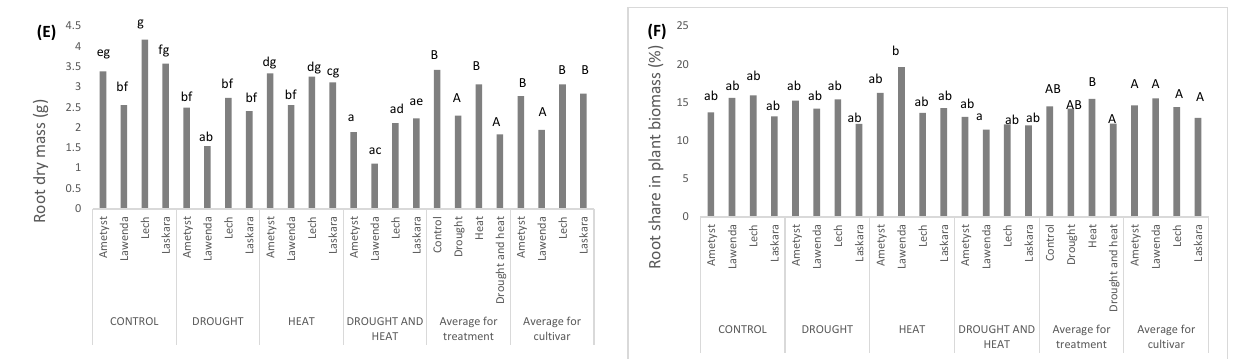
Figure 1. Average value of tested morphological parameters ( A ) plant height; ( B ) Leaves dry mass; ( C ) Stems dry mass; ( D ) Leaves area; ( E ) Root dry mas; ( F ) Root share in plant biomass; per plant of selected potato cultivars under drought, heat and both stresses applied simultaneously. a, b, c, A, B, C-values in the same column followed by the same letter do not significantly differ ( p < 0.05), as per Tuckey’s test.